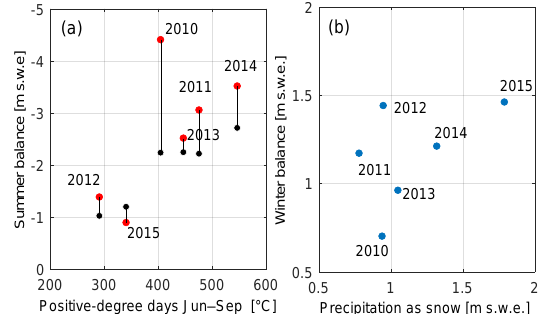
Figure 7. Summer (a) and winter (b) balance plotted against sum- mer temperature (positive-degree days) and estimated precipitation as snow respectively. For the summer balance, the black markers are calculated melt using a degree-day model with typical values calibrated from nearby glaciers (3.5mm ◦ C − 1 day − 1 for snow and 7.5mm ◦ C − 1 day − 1 for ice). Winter precipitation is obtained from seNorge (Engeset et al.,